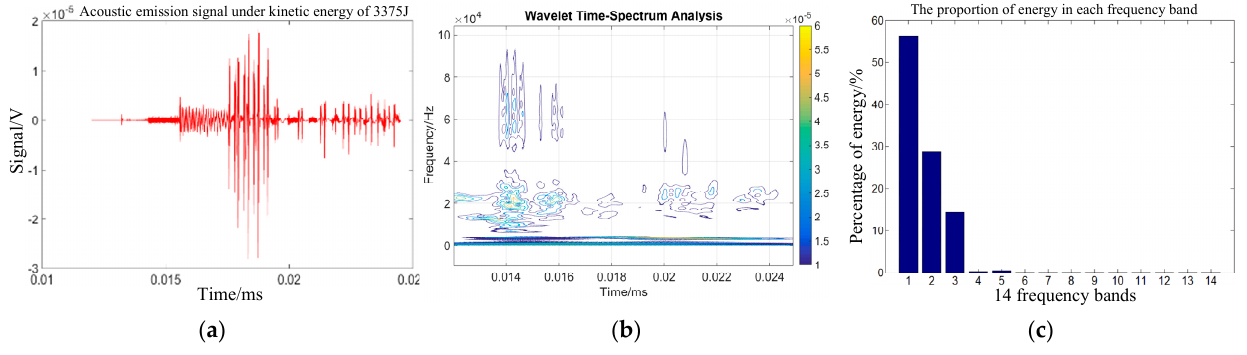
Figure 5. Time-frequency analysis of target sound emission signals under 3375 J kinetic energy. ( a ) Acoustic emission time domain waveform. ( b ) Sound emission wavelet time spectrum. ( c ) Acoustic transmitted signals for each frequency band.